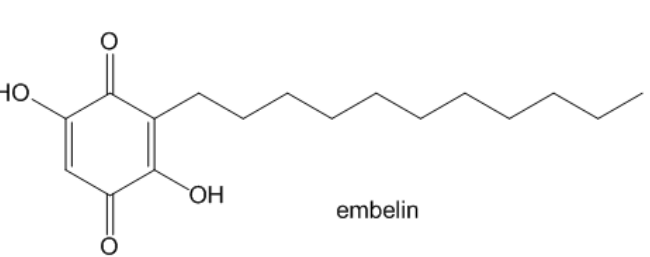
Figure 1. Molecular structure of